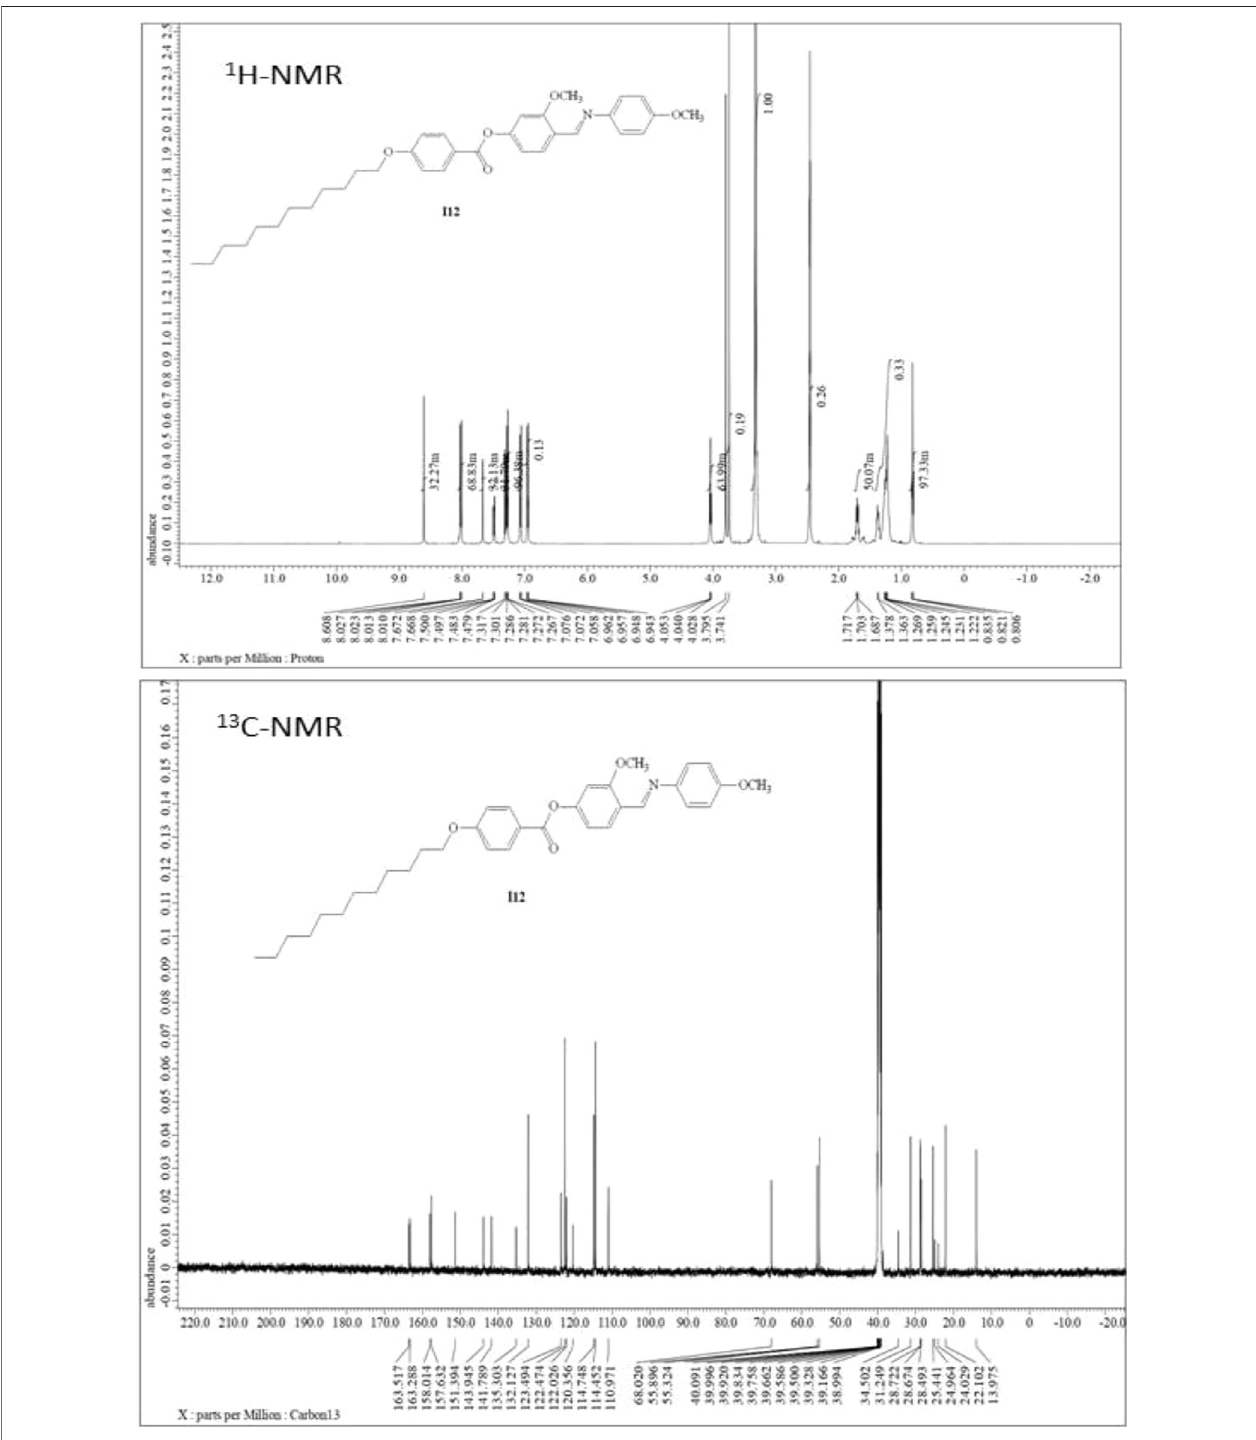
FIGURE 3 | NMR spectra of material A12